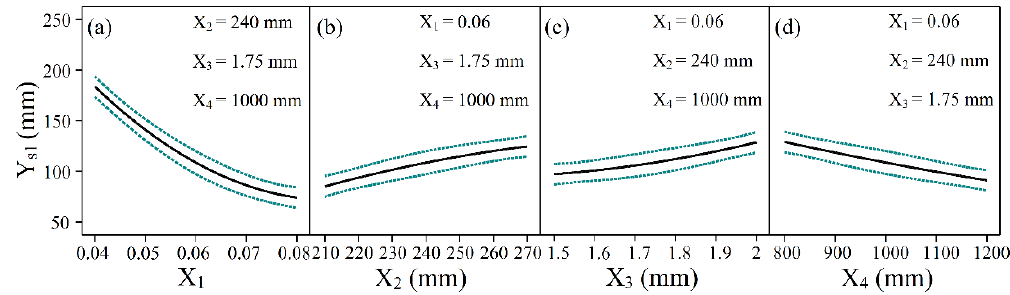
Figure 10. Effect of various factors on the longitudinal radius of positive Gaussian curvature surface: ( a ) Maximum com- pression ratio; ( b ) Sheet width; ( c ) Sheet thickness; ( d ) Transverse curvature radius.